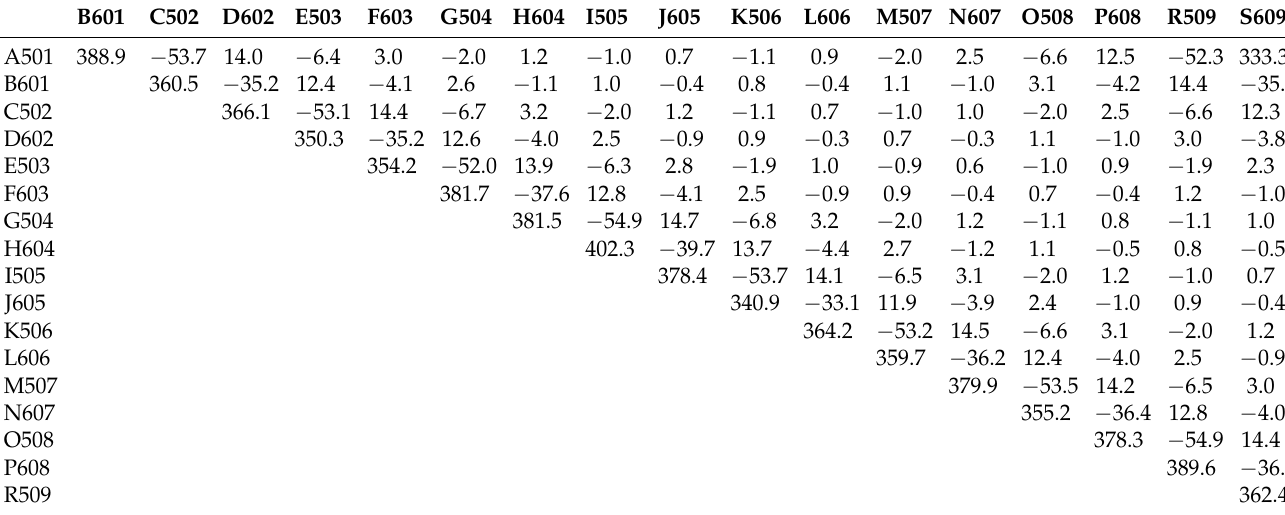
Table A2. Interaction energies between BChl molecules in the B850 ring, calculated in the dipole–dipole approximation. The Q y transition moments are considered to be collinear to the NB–ND direction of the porphyrin ring of BChl. The crystal data were taken from 2fkw.pdb file.